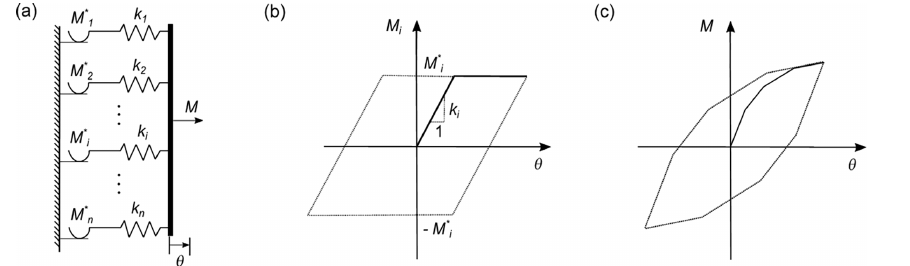
Figure 7. Non-linear 1-D model as a combination of spring–slip elements: (a) physical representation, (b) load-displacement behaviour of each spring and slip element, and (c) resulting load-displacement behaviour of all the parallel coupled springs and slip elements.